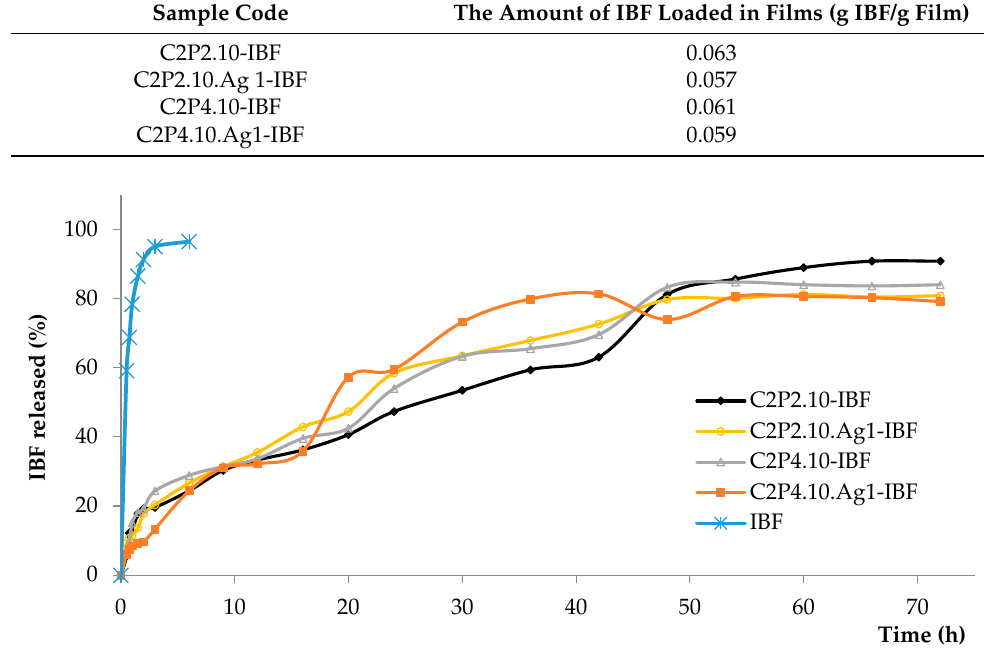
Figure 9. In vitro release kinetics of simple IBF and IBF from films in PBS (pH 6.8).